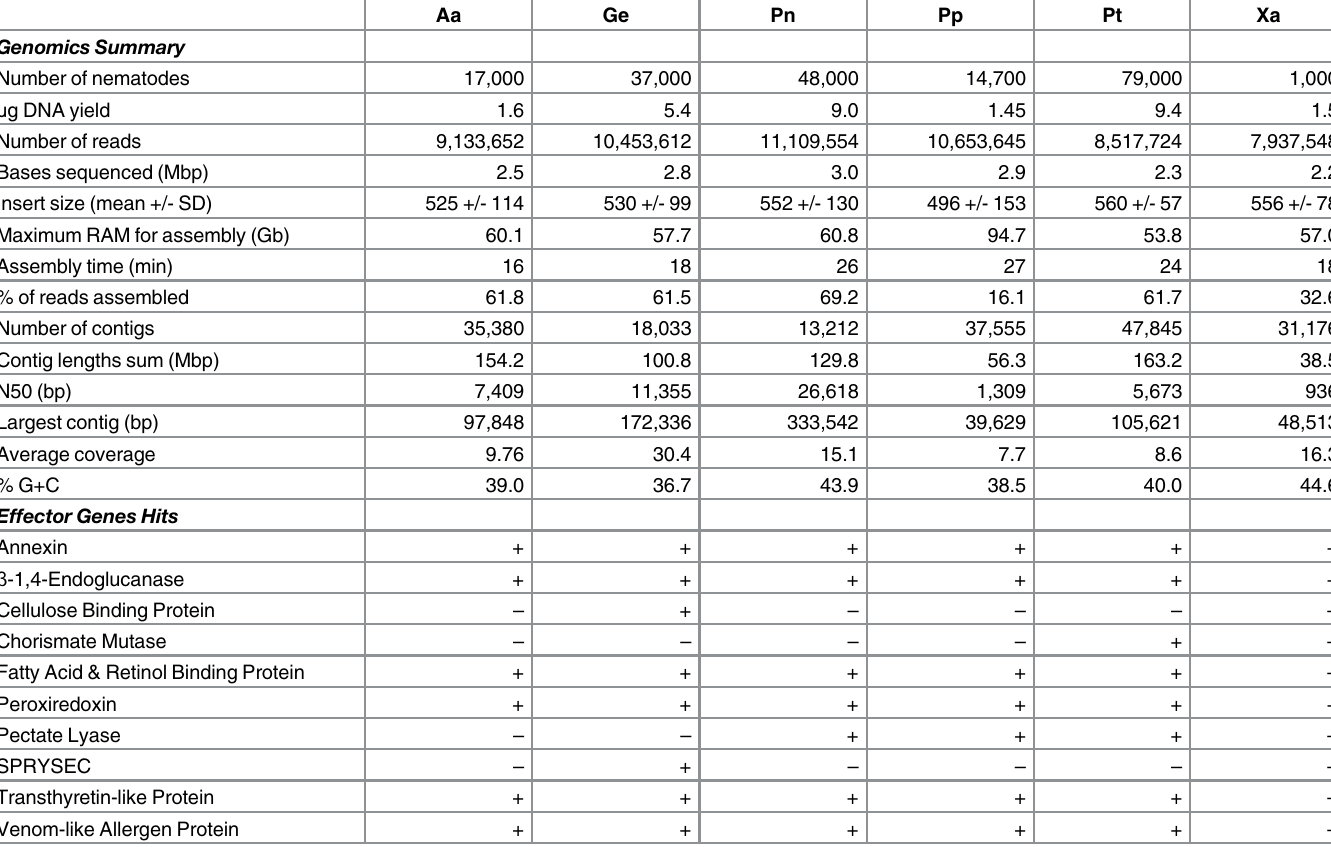
Table 1. Genome skimming summary information and effector gene